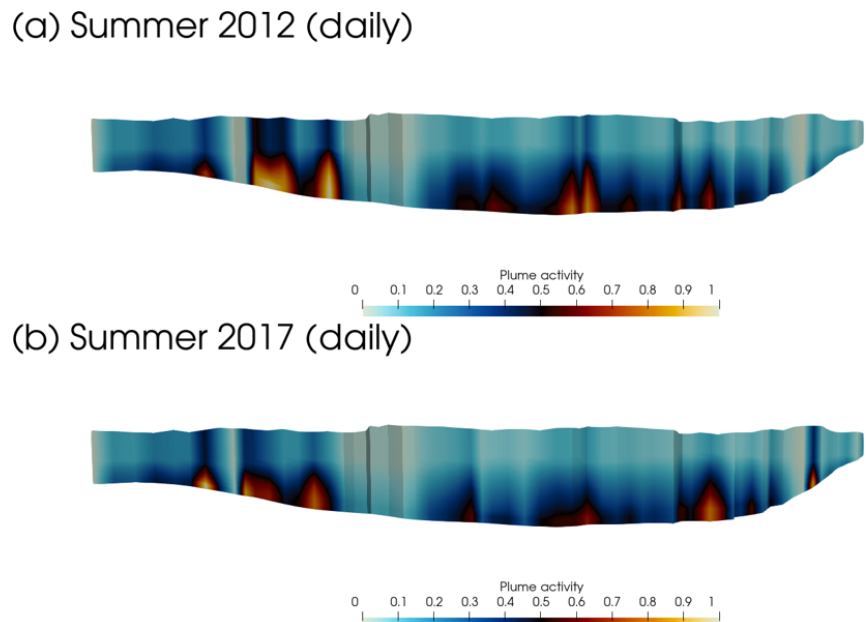
Figure 10. Heat map of plume activity in (a) SummerDaily12 and (b) SummerDaily17 simulations. Areas with a value of 1 show the highest mean plume melt rates across the entire length of the model run; areas with a value of 0 show no plume activity at any point.